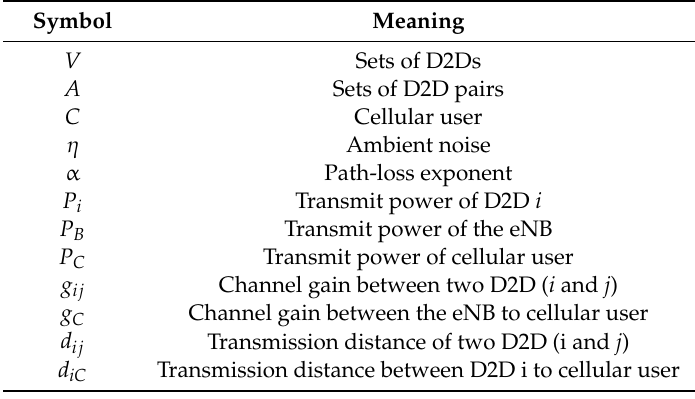
Table 1. Summary of notation.